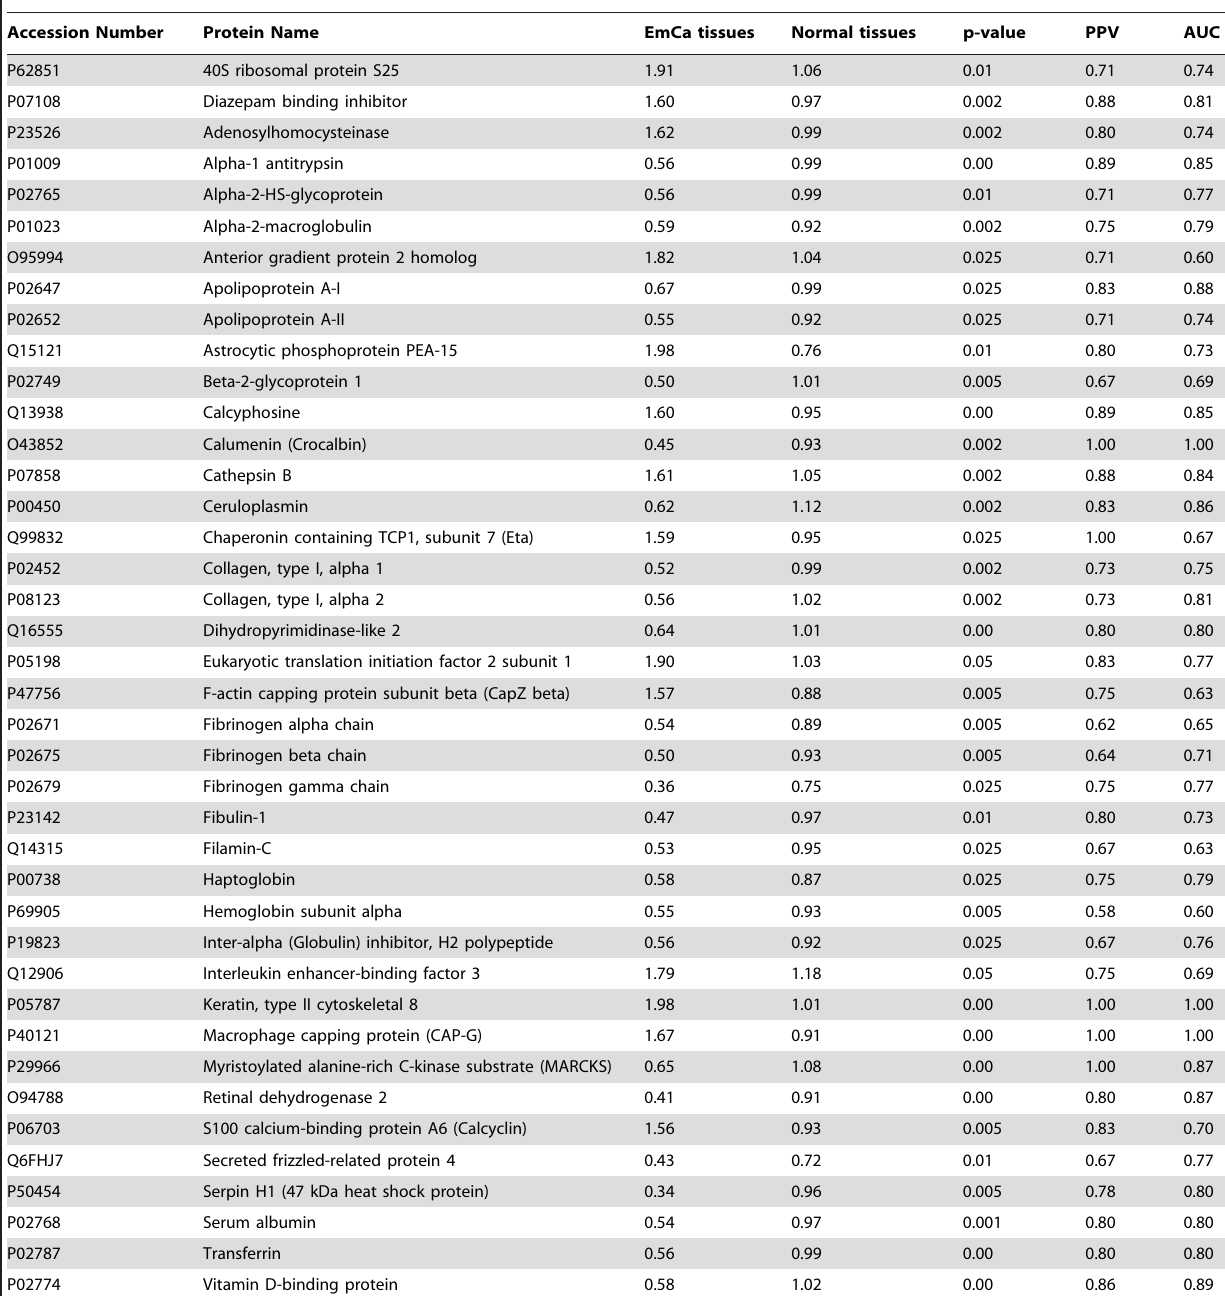
Table 2. Mean iTRAQ ratios for potential EmCa molecular